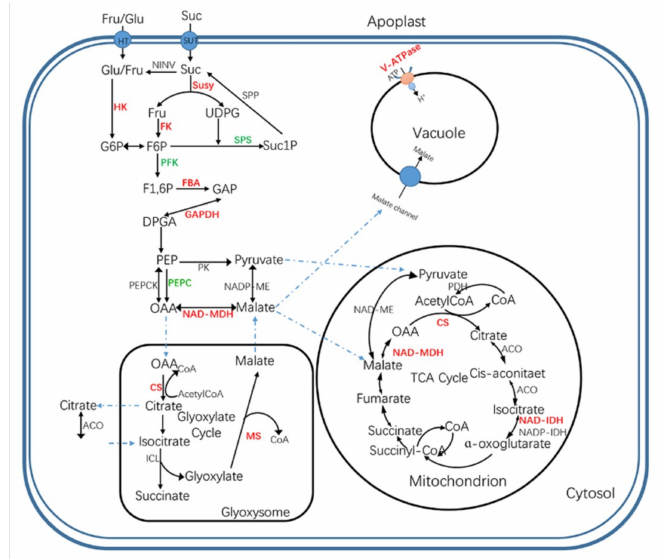
Figure 6. Metabolic network of soluble sugar and organic acid in apple fruits between M. sargentii and M. niedzwetzkyana . The red and green colors represent the proteins with up- and down-regulation in mature apple fruits in M. sargentii compared with that in M. niedzwetzkyana